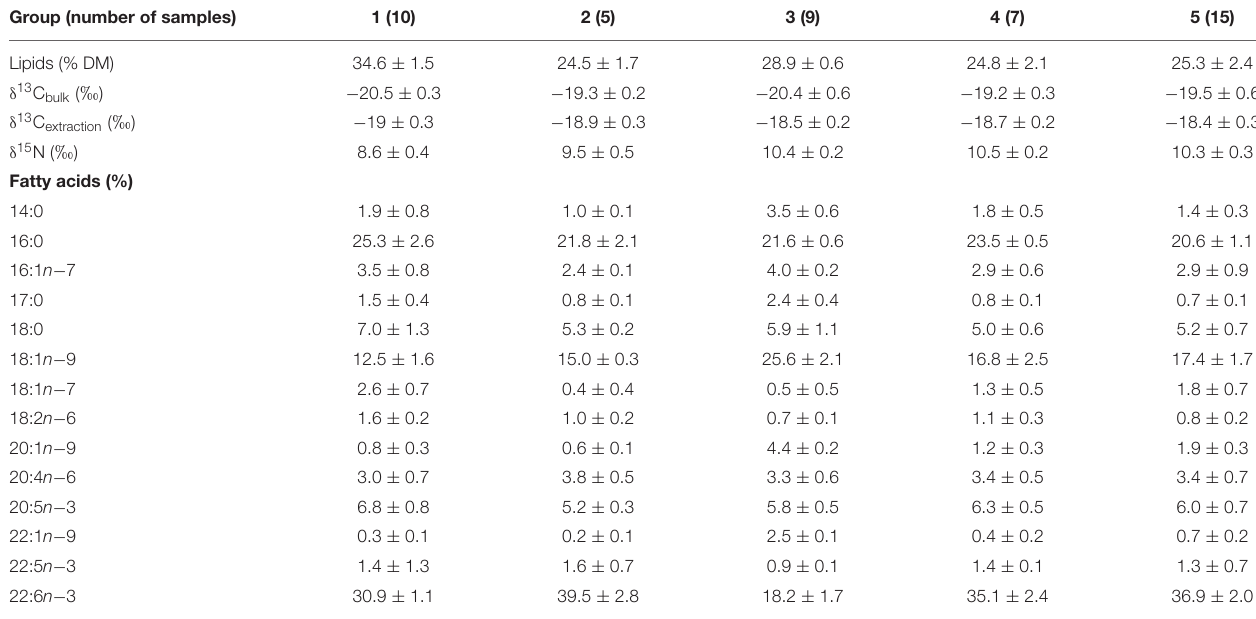
TABLE 3 | Lipids and isotopes [lipids % of dry mass (DM)], δ 13 C bulk